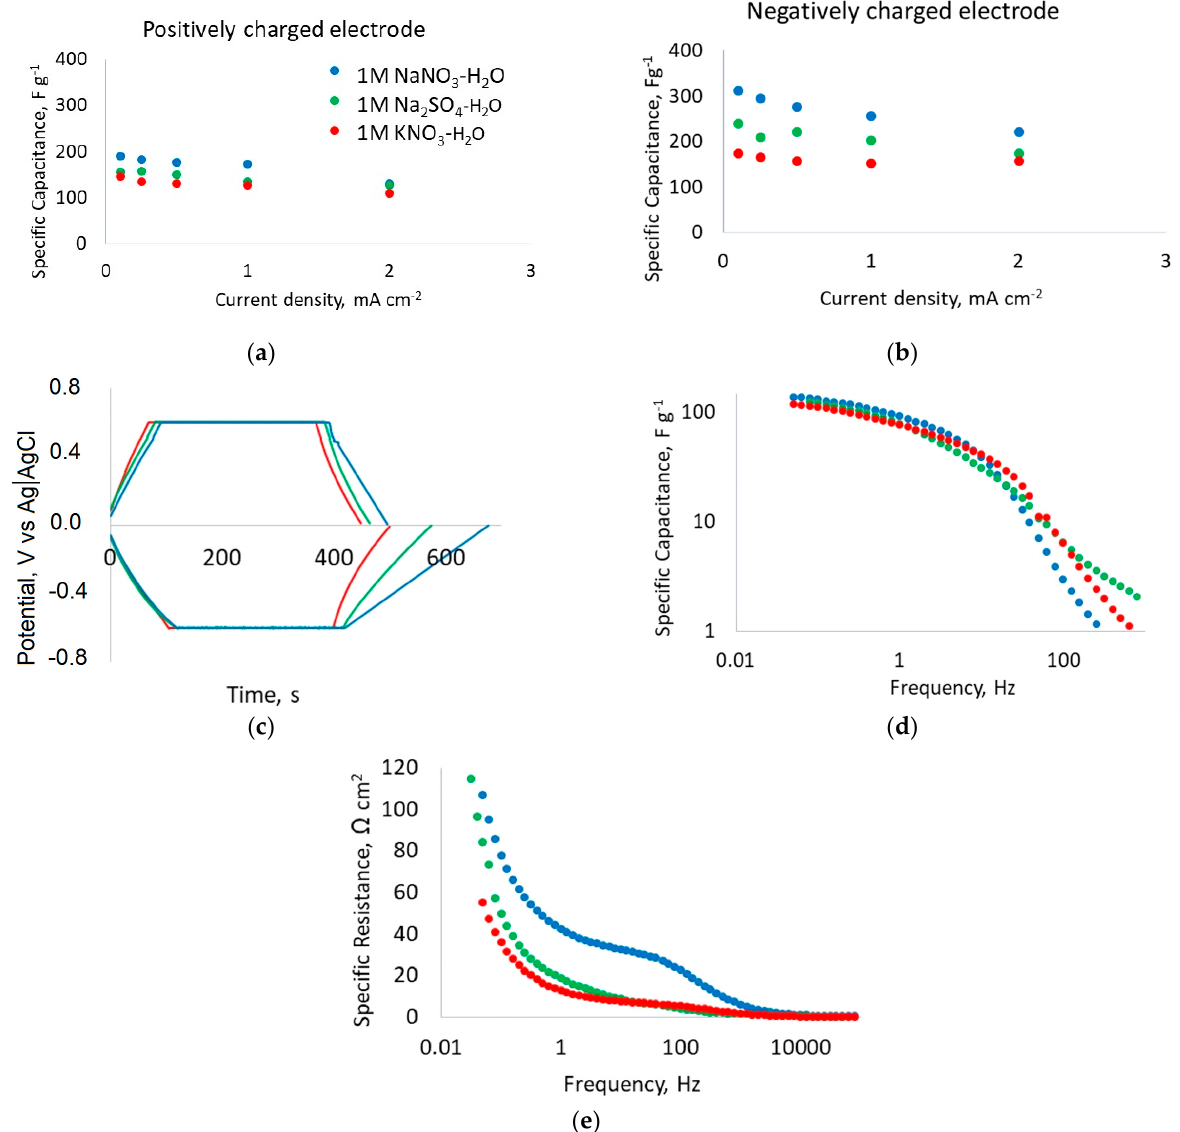
Figure 6. Electrochemical performance of “electropsun” CDC based fibrous electrodes in aqueous electrolytes: ( a , b ) specific capacitance values from CC discharge plots at I = 0.5 mA cm − 2 for positively and negatively charged electrodes, ( c ) CC charge–discharge, curves I = 0.5 mA cm − 2 ( d ) specific capacitance, C s as a function of frequency and ( e ) resistance, R s as a function of frequency from EIS measurements at 0 V vs. Ag|AgCl. Table 3. Gravimetric capacitance values for positively and negatively charged electrodes evalu- ated by CC tests at a current density of 0.5 mA cm − 2 in 1 M solutions.